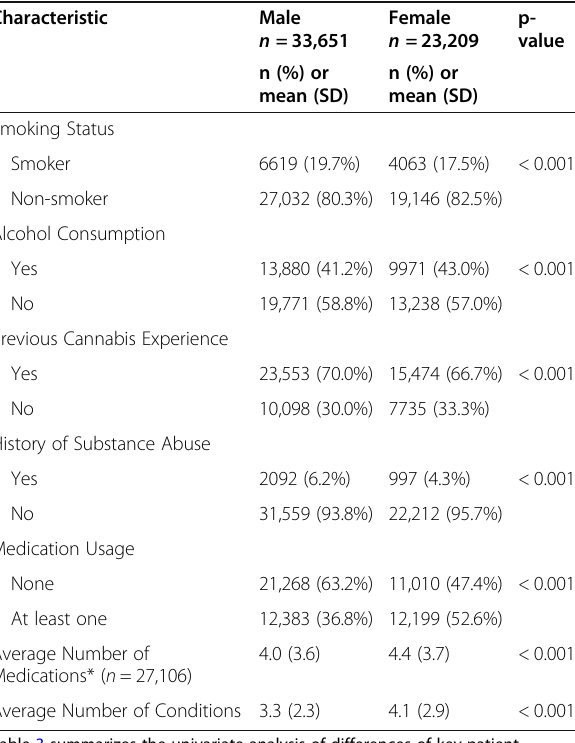
Table 2 Univariate analysis of differences of key characteristics of 61,379 patients seeking medical cannabis certification by age Characteristic